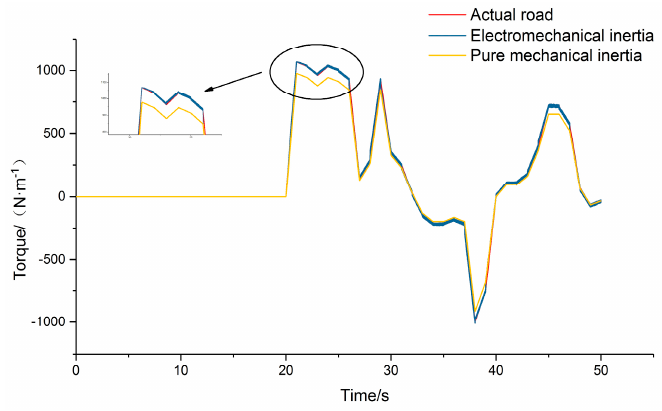
/ braking torque Figure 9. Comparison of driving/braking torque output. Figure 9. Comparison of driving Figure 9. Comparison of driving/braking torque output.